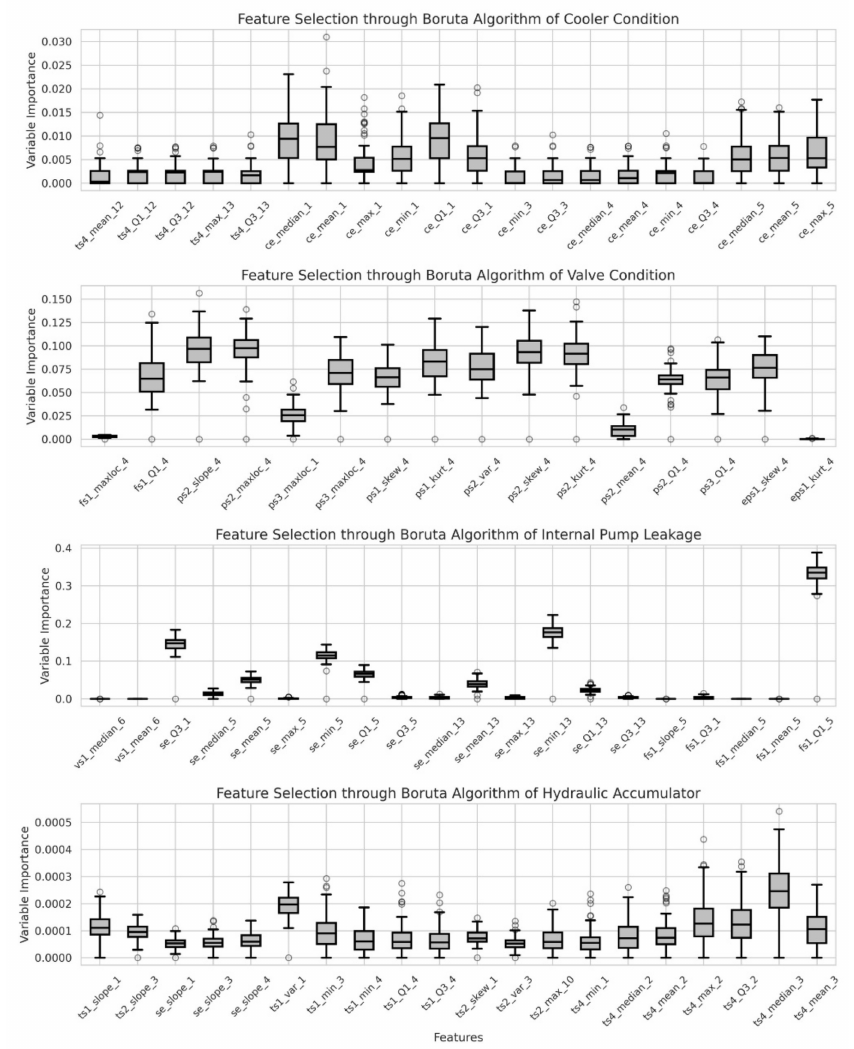
Figure 4. Feature selection through the Boruta